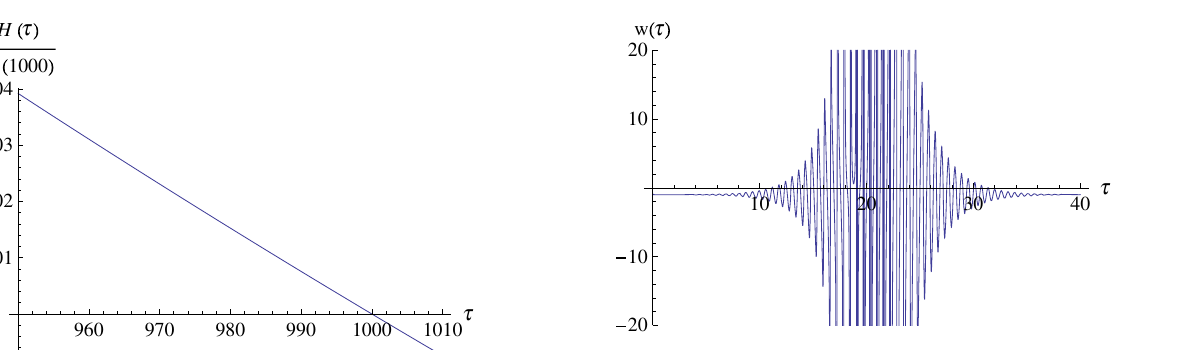
Fig. 9 The typical dependence w(τ) . This example is for α = 0 . 09 = 10 120 . Note that after the intermediate phase of oscillations, = 10 120 . and E 0 3 H 2 0 3 H 2 0 the function w(τ) can be treated as a constant, which is equal to − 1. The rescaled time τ is given in units of [ 1 . 3 × 10 − 144 s